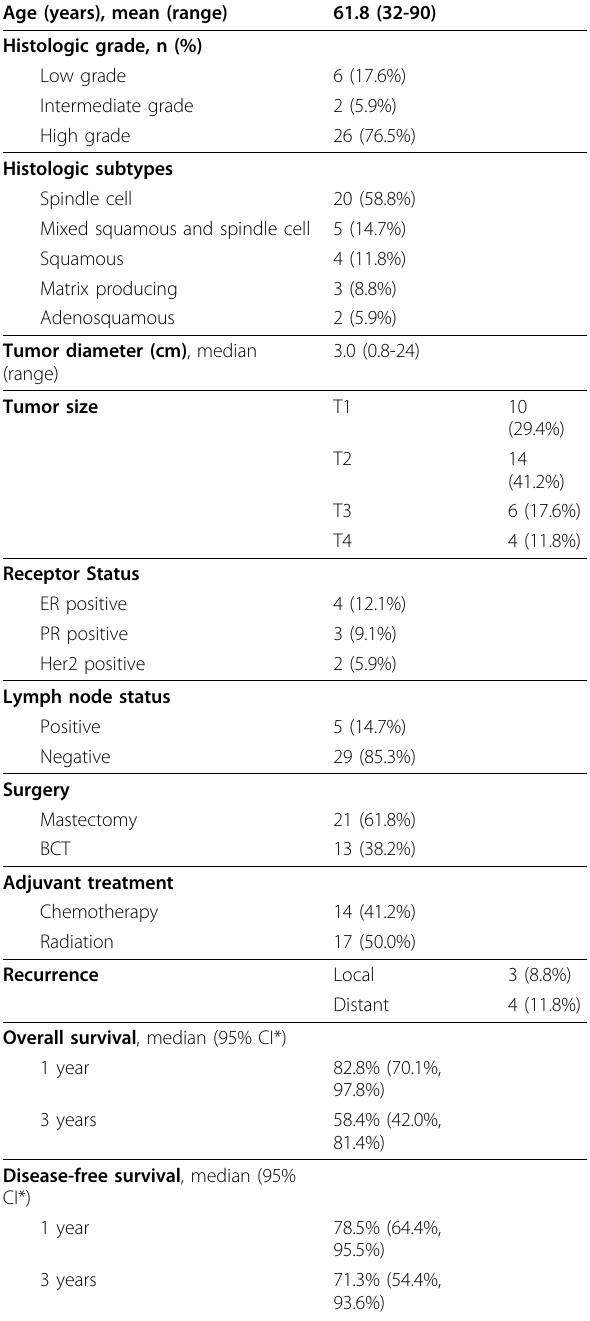
Table 1 Clinicopathologic factors of 34 patients with metaplastic breast